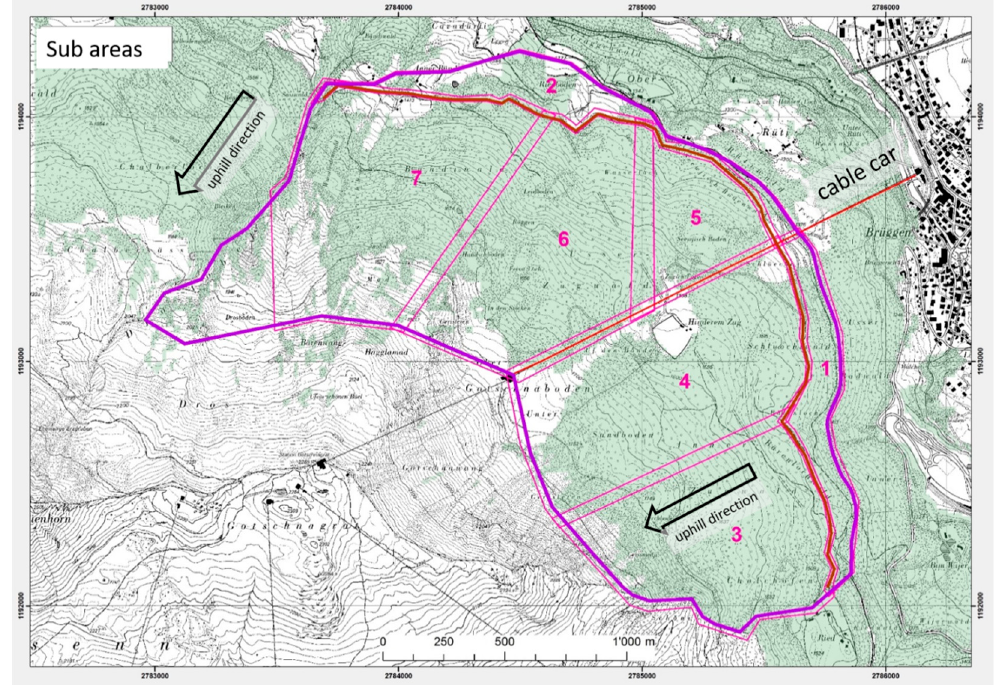
Figure 6. Sub-areas (numbered) in the Gotschna area subject to computation (topographic map © swisstopo (JA100118)).